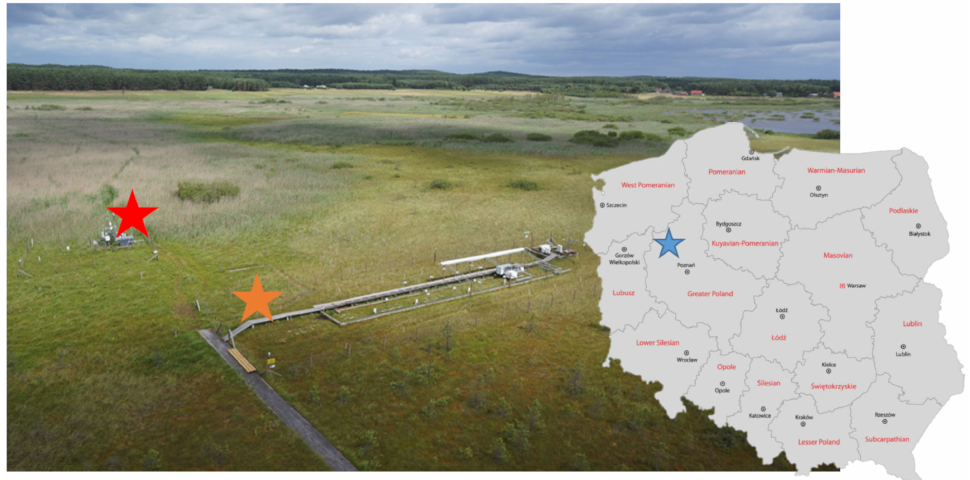
Figure 1. Location of the Rzecin peatland in Poland (blue star); eddy covariance tower (red star); sun radiometer tower (orange